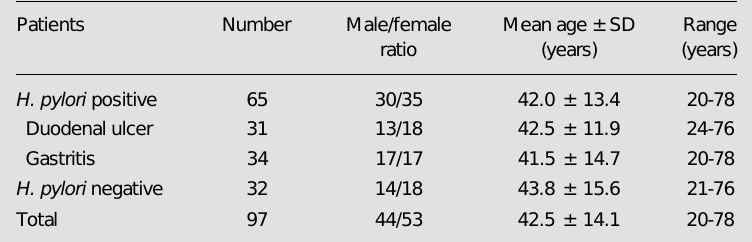
Table 1 - Characteristics of the population studied.